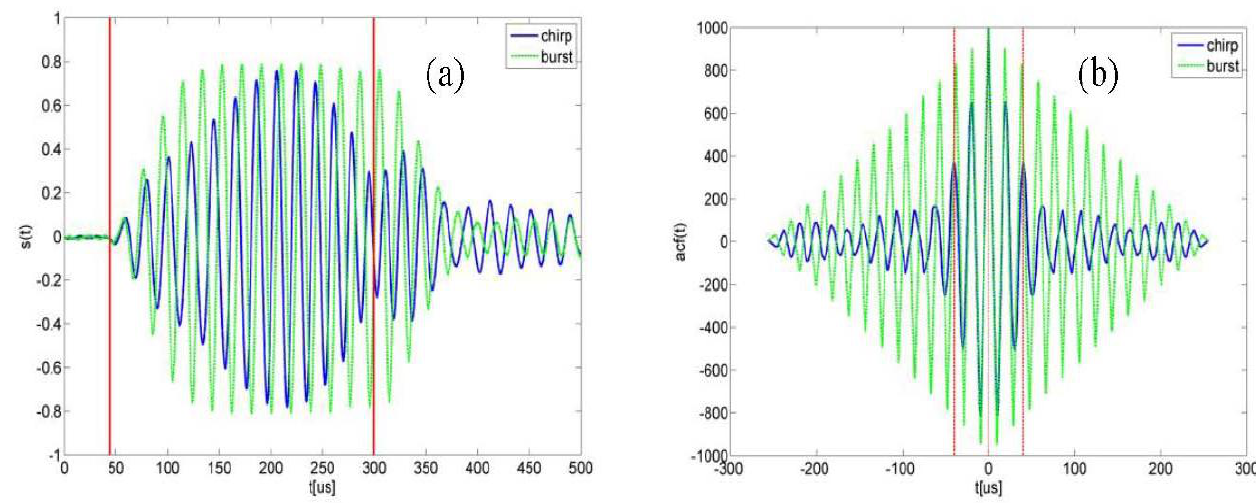
Figure 5. ( a ) Received (analog) waveforms for burst with f settings from Figure 3; ( b ) Binary autocorrelation function showing pulse compression properties of the chirp compared to a